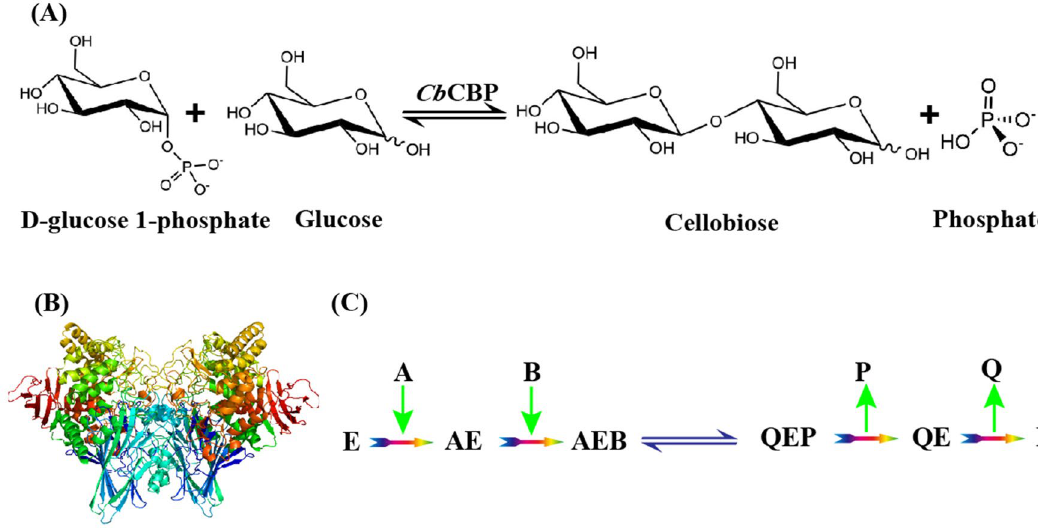
Figure 1. ( A ) Reversible phosphorolysis reaction catalyzed by Cb CBP. ( B ) Three-dimensional structure of the Cb CBP (PDB-entry 3qde) through homology modeling. The structure of the Cb CBP monomer consists of four distinct regions: an N-terminal domain, a helical linker region, an α-helix barrel domain, and a C-terminal domain. ( C ) Substrate binding and product release order for phosphorolytic reactions (E, Cb CBP; A, Pi; B, cellobiose; P, Glucose; Q,